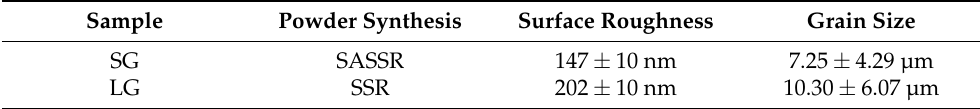
Table 1. Summary of synthesis route information leading to different grain sizes in the